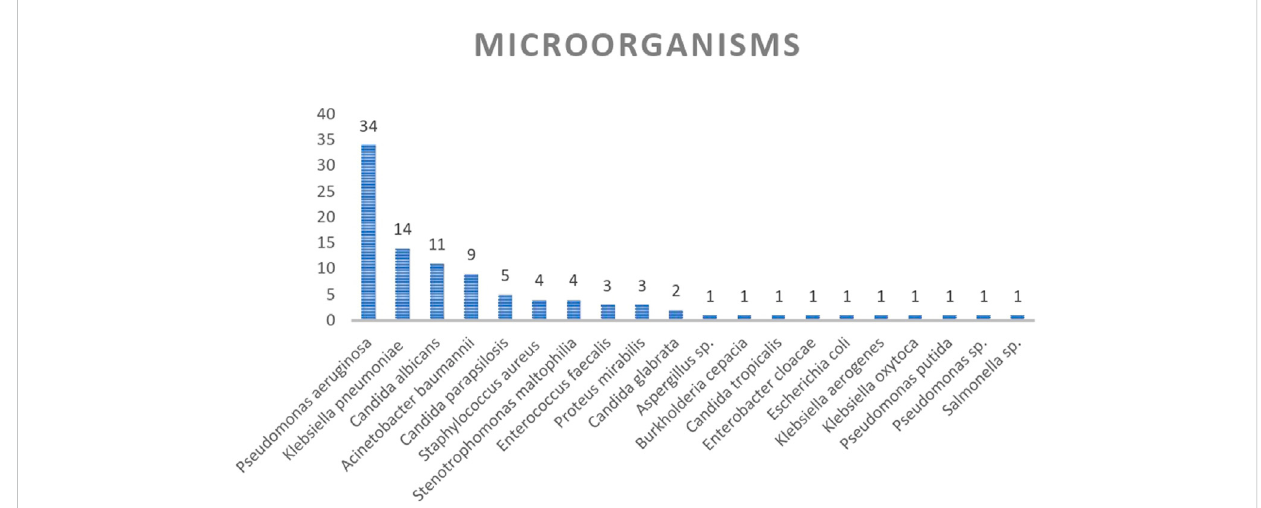
Microorganisms isolated in hospitalized COVID-19 patients with multiple infections.